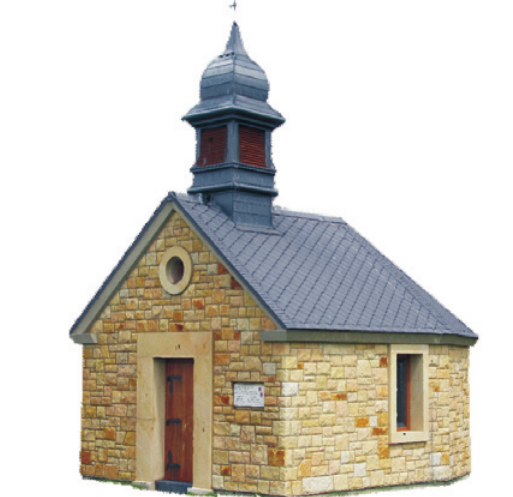
Fig. 8. 3D model of a well-textured chapel